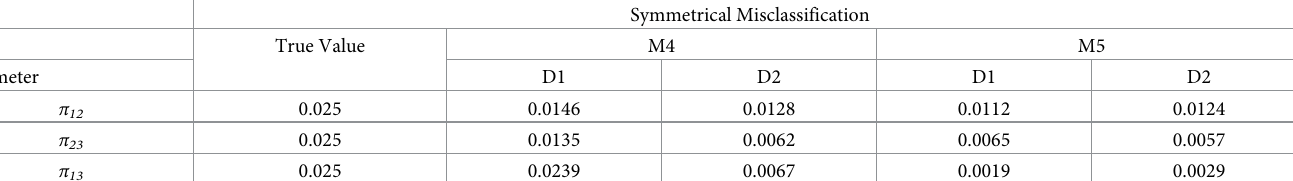
Table 3. Posterior mean of the misclassification probability between the different categories of the discrete responses and datasets 1